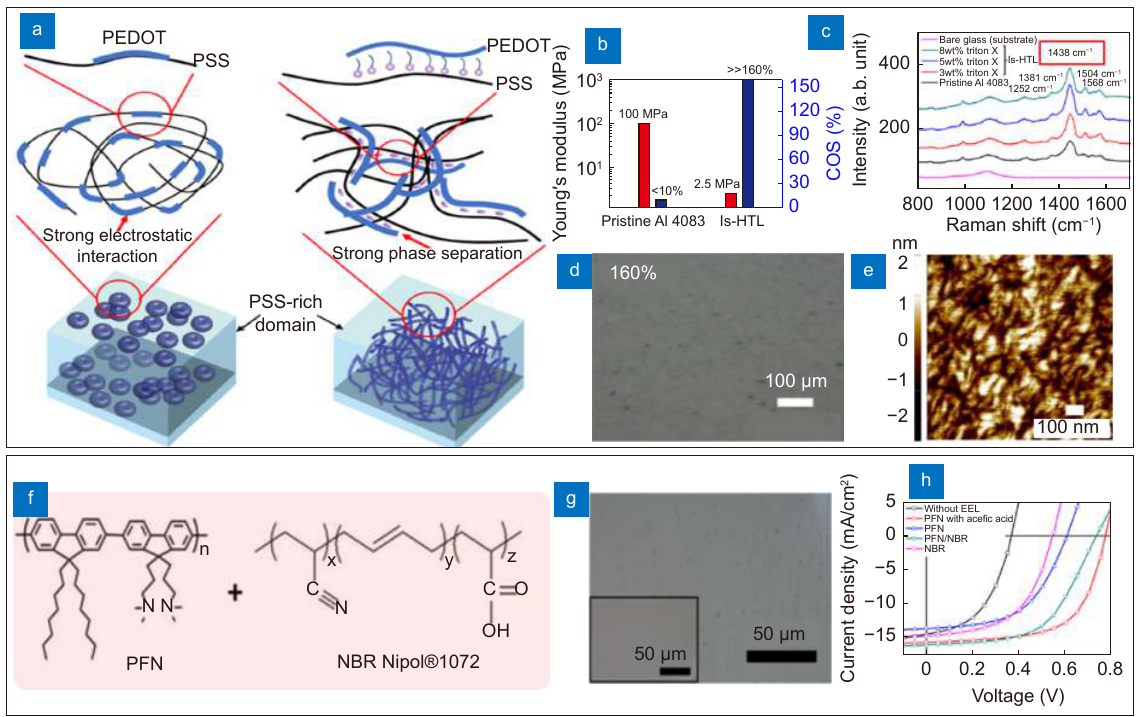
Fig. 6 | Charge transport materials with intrinsic stretchability. ( a ) Intrinsically stretchable hole transport layer of Triton X-added PEDOT:PSS. ( b ) Young’s modulus and crack onset strain (COS) of pristine and Triton X-added PEDOT:PSS layer. ( c ) Raman spectroscopy ana- lysis. ( d ) SEM and ( e ) AFM images of the film after applying strain of 160%. ( f ) Intrinsically stretchable electron transport layer based on NBR and PFN. ( g ) Optical microscope image showing clean film without any cracks developed after applying 60% strain. ( h ) Current-voltage characterist- ics of the hybrid film. Figure reproduced with permission from: (a–e) ref. 108 , under a Creative Commons Attribution NonCommercial License 4.0. (f–h) ref. 166 , American Chemical